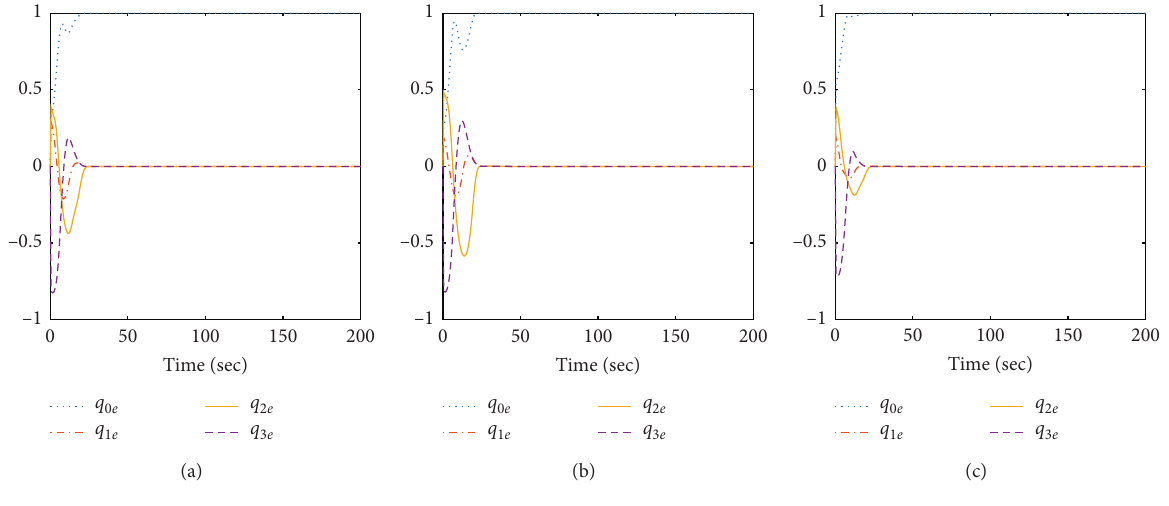
Figure 3: The curves of the relative attitude error. (a) Sat1. (b) Sat2. (c)